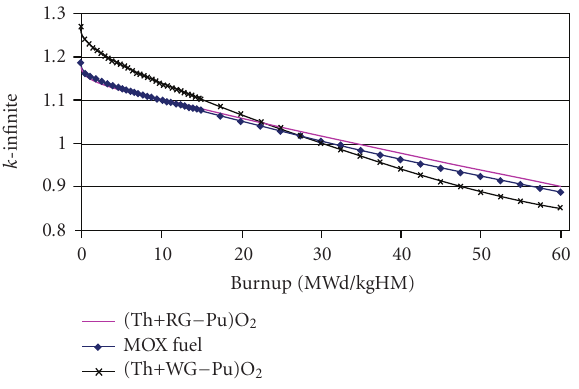
Figure 4: k -infinite as a function of burn-up